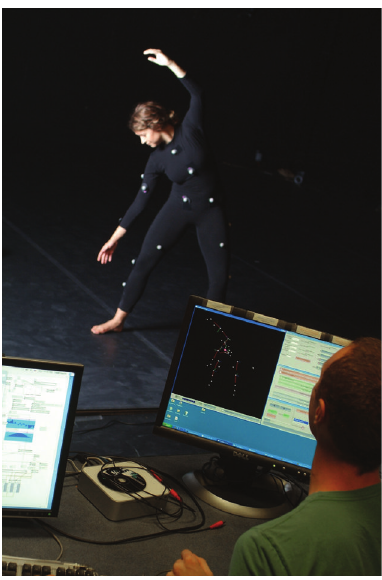
Figure 5: Image of a user interacting in the Response environment, which incorporates our SQ analysis framework.